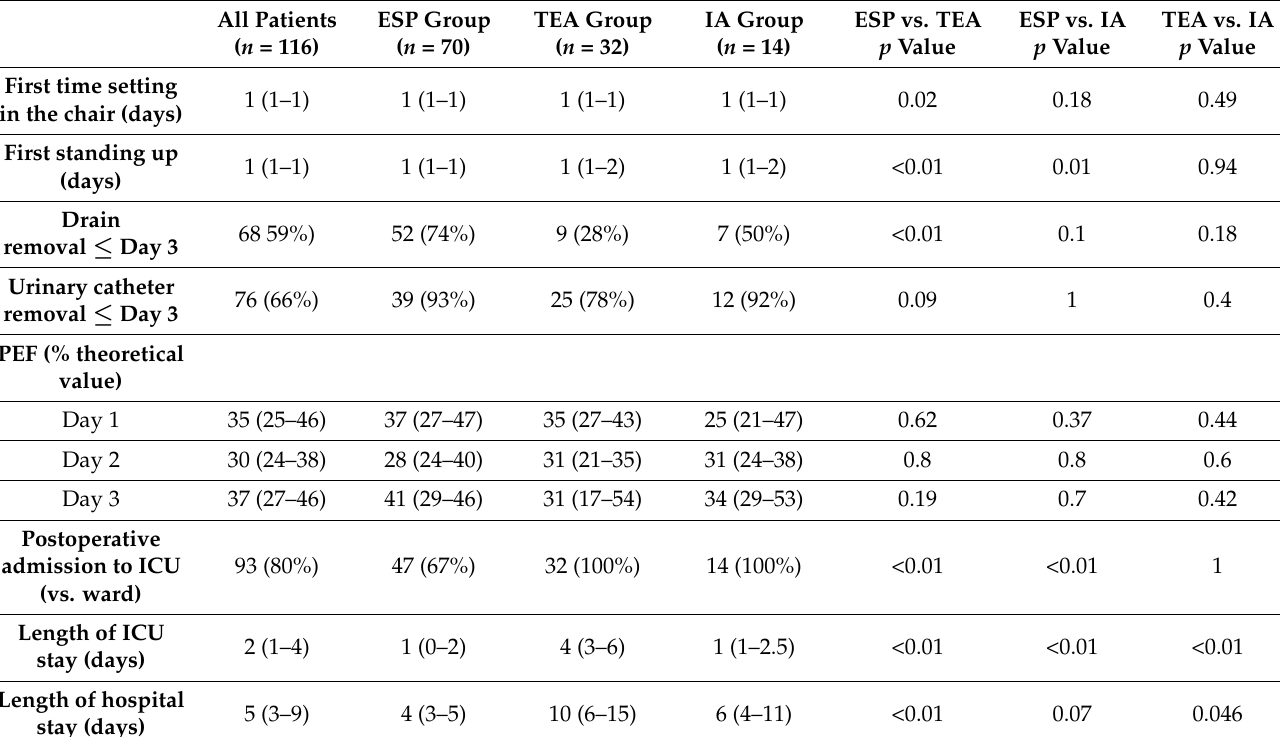
Table 4. Postoperative recovery